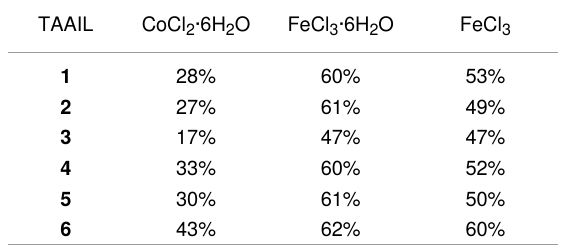
Table 1: Yields achieved with TAAILs 1 – 6 and different catalysts a .